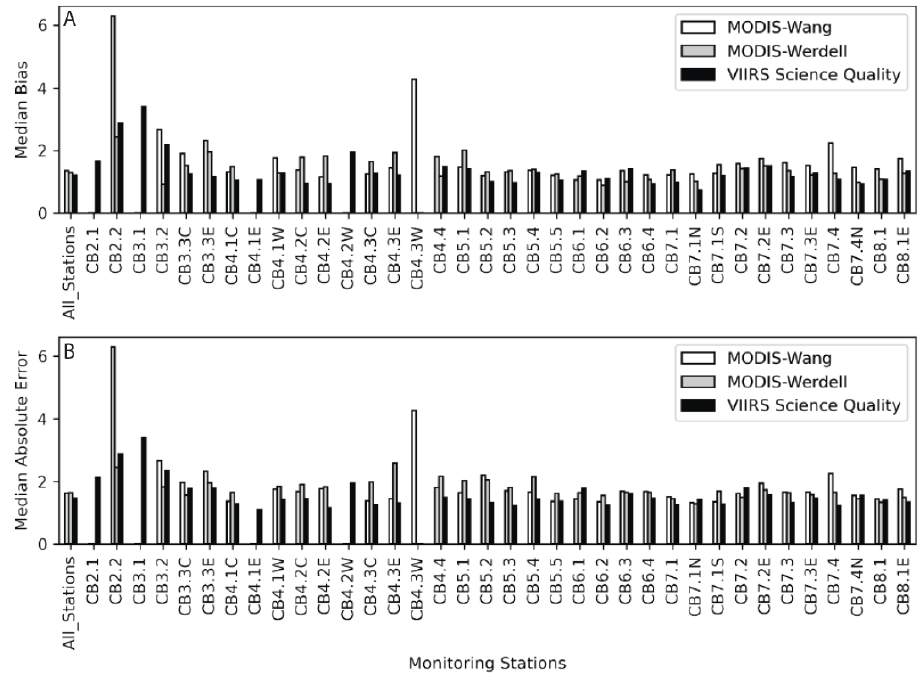
Figure 10. ( A ) Median bias from the field data and the MODIS-Wang (white), MODIS-Werdell (gray), and VIIRS-SciQual (black) imagery for each station from the CBP. The stations run from left to right and represent a transect from the head of the bay to the mouth of the bay (Figure 1). Values closer to 1 indicate less bias. ( B ) Median Absolute Error (MedAE) is presented in the same fashion as the bias.